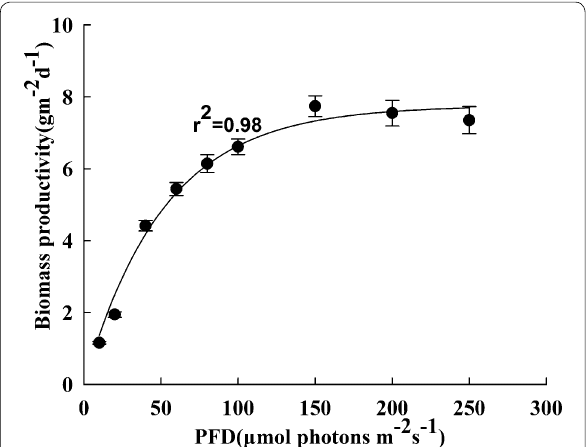
Fig. 5 Effect of light intensity on growth of B. braunii SAG807‑1 under attached cultivation. Data are means